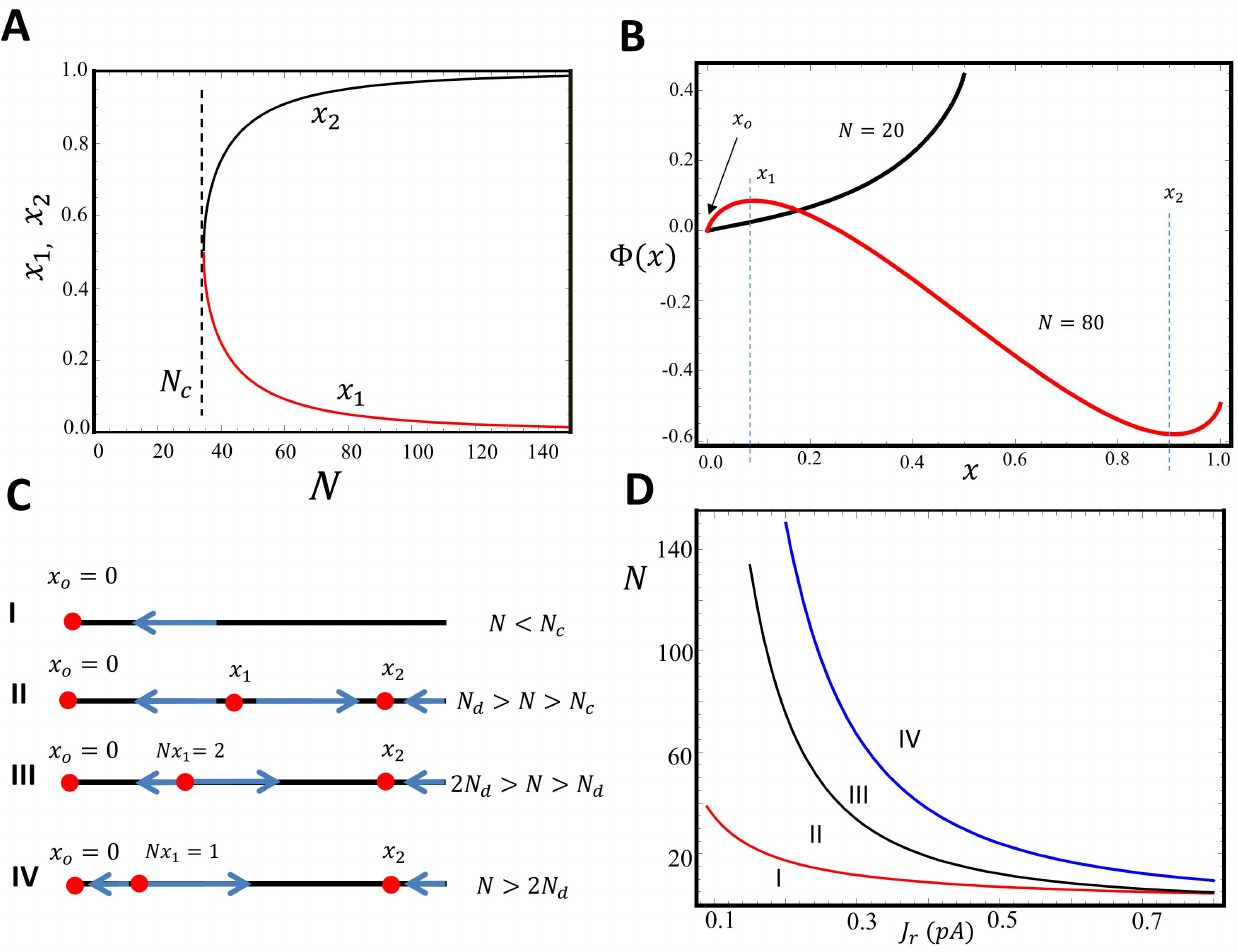
Figure 2. (A) Plot of location of fixed points x 1 and x 2 as a function of cluster size N . Parameters used are shown in Table 1, where we have fixed J r ~ 0 : 1 pA , and k z ~ 10 { 5 ( m M ) { 2 ms { 1 . The system exhibits bistability for cluster sizes that exceed N C ~ 34 channels. (B) The plot for the effective potential W ( x ) as a function of x . The black and red lines denote the plot for the cluster size N ~ 20 and N ~ 80 , respectively. For the case N ~ 80 , positions x o and x 2 denote the location of local minima, and x 1 is a maxima. (C) Illustration of fixed points corresponding to the four distinct scenarios. (D) Plot of demarcation lines, in the N vs J r plane, separating the four different fixed point scenarios.